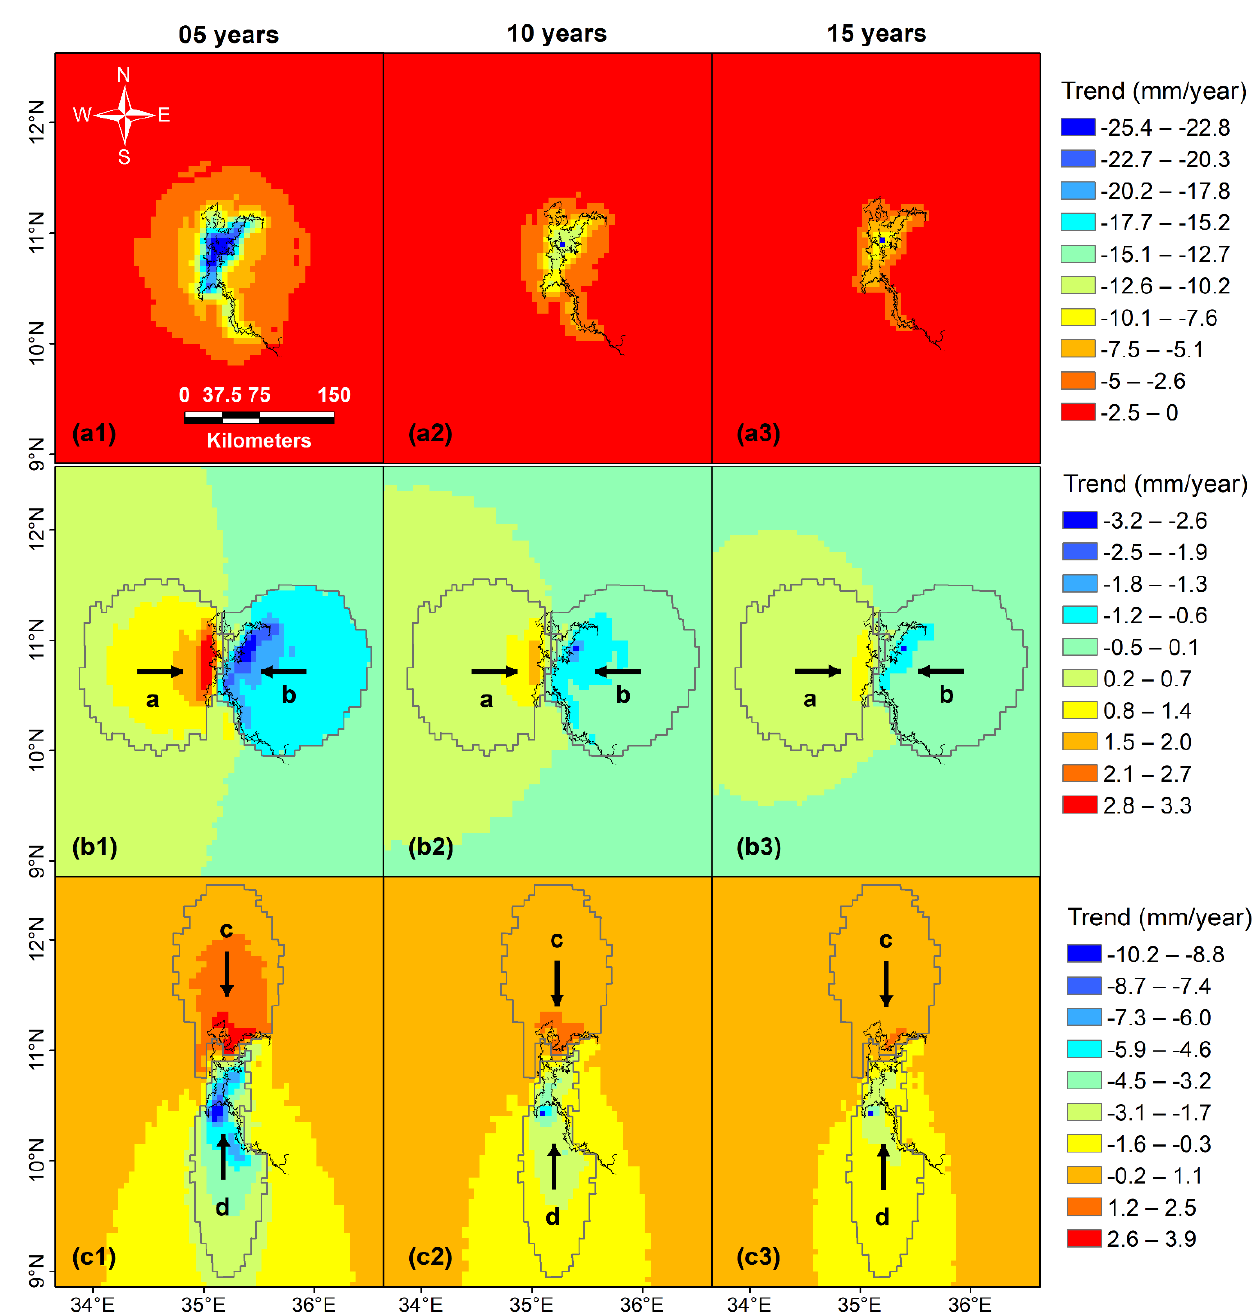
Figure 7. Trends in vertical ( top row ), east ( middle row ), and north ( bottom row ) components of land deformation, computed based on 5-year ( left column ), 10-year ( middle column ), and 15-year ( right column ) GERD reservoir filling strategies. Different color scales are used for different